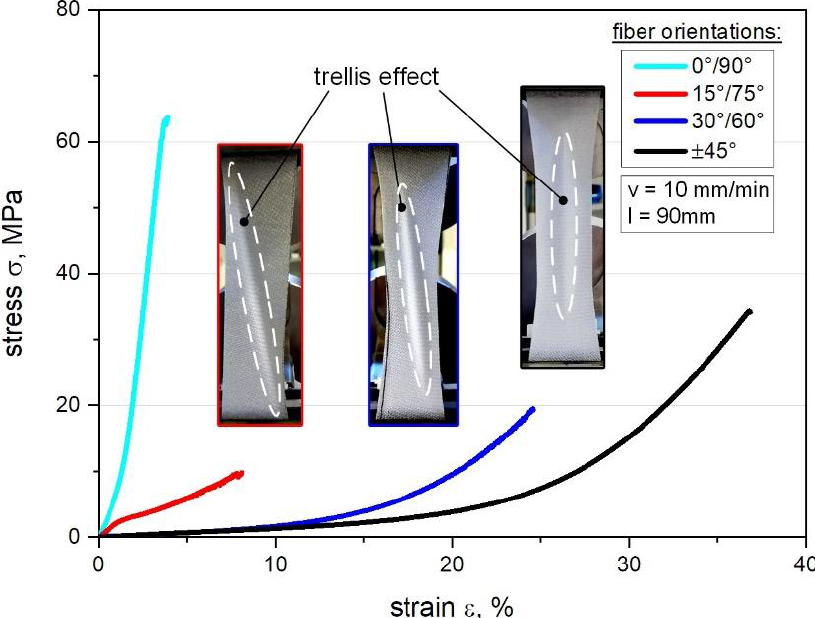
Figure 4. Comparison of stress-strain curves of the different fiber orientations (±45°, 30°/60°, 15°/75° and 0°/90°) for the GF-PDMS composite with textile reinforcement as obtained from composite tensile tests with the accompanying trellis effect related to the wrinkling and out-of plane shearing.